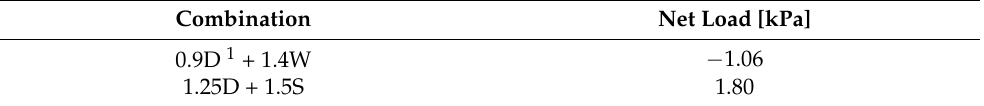
Table A3. Load Combinations as per NBCC 4.1.3.2. Based on Design Dead, Snow, and Wind